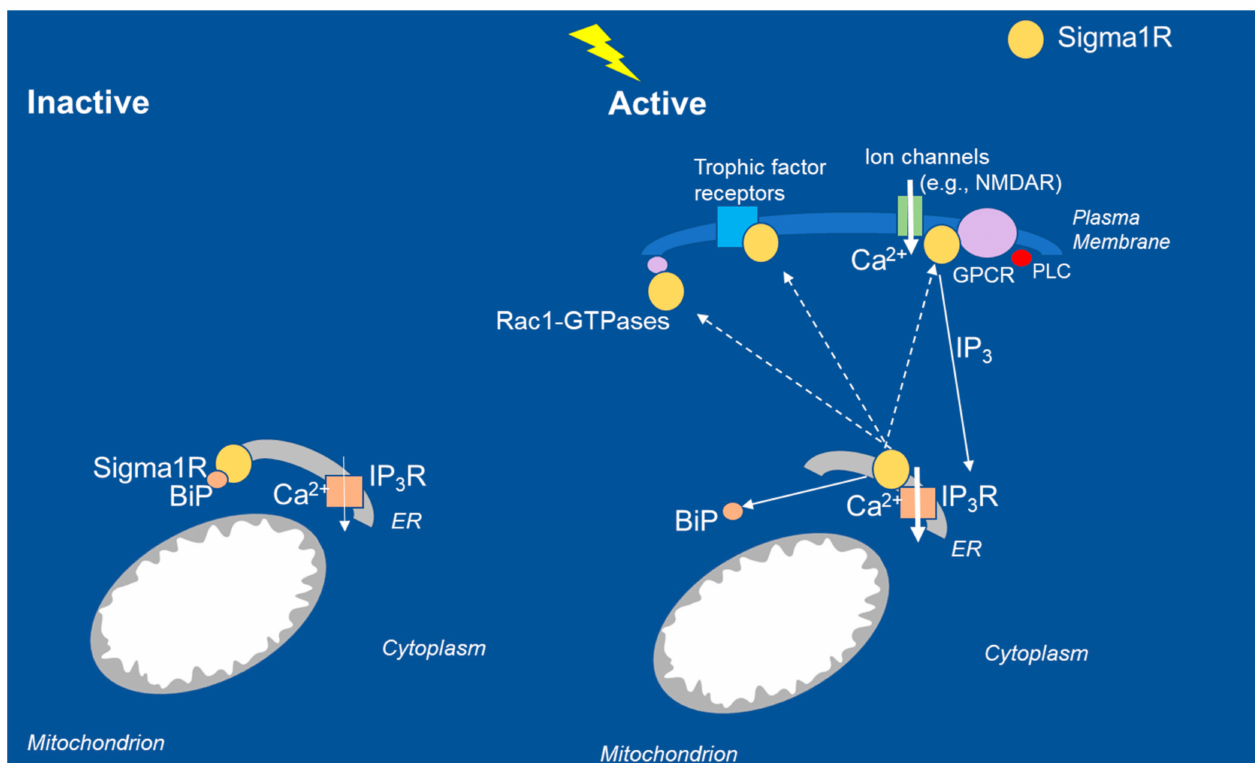
Figure 2. Intracellular interactions of Sigma1R chaperone proteins in inactive and active states. In the resting state, Sigma1R associates with the regulatory protein BiP at the ER MAM. During seizures, loss of GABAergic tone results in excessive NMDAR-mediated calcium influx in glutamatergic neurons. The Sigma1R translocates to the plasma membrane or the ER plasmalemmal space, where it interacts with client proteins, including ion channels (e.g., NMDA, sodium, potassium, voltage-regulated chloride), trophic factor receptors, and kinases; interaction with Rac-GTPases promotes dendritic spine formation and affects neuronal redox processes. For comprehensive consideration of intracellular interactions, see Su 2010, Hayashi and Su 2005, Voronin 2020, Rosseaux and Greene 2015, Vavers 2019, and Maurice 2020. BiP, binding immunoglobulin protein; Ca 2+ , calcium; ER, endoplasmic reticulum; GPCR, G-protein − coupled receptor; GTPase, hydrolase enzyme of guanosine triphosphate; IP 3 R, inositol triphosphate receptor; MAM, mitochondrial associated membrane; NMDAR, N - methyl- D